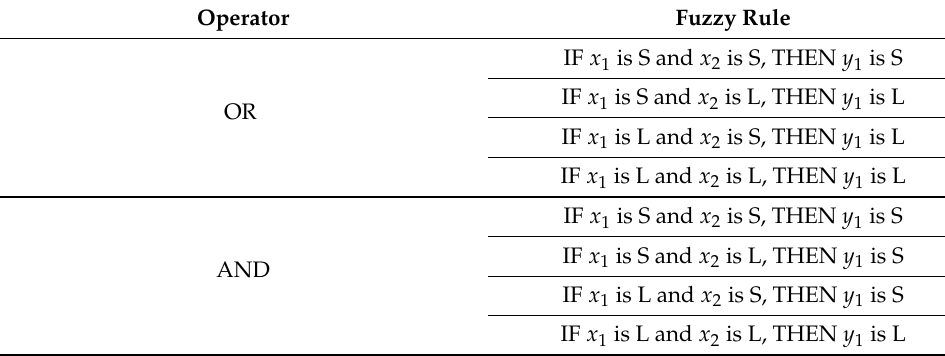
Table 2. The benchmark of fuzzy rules for discrete data